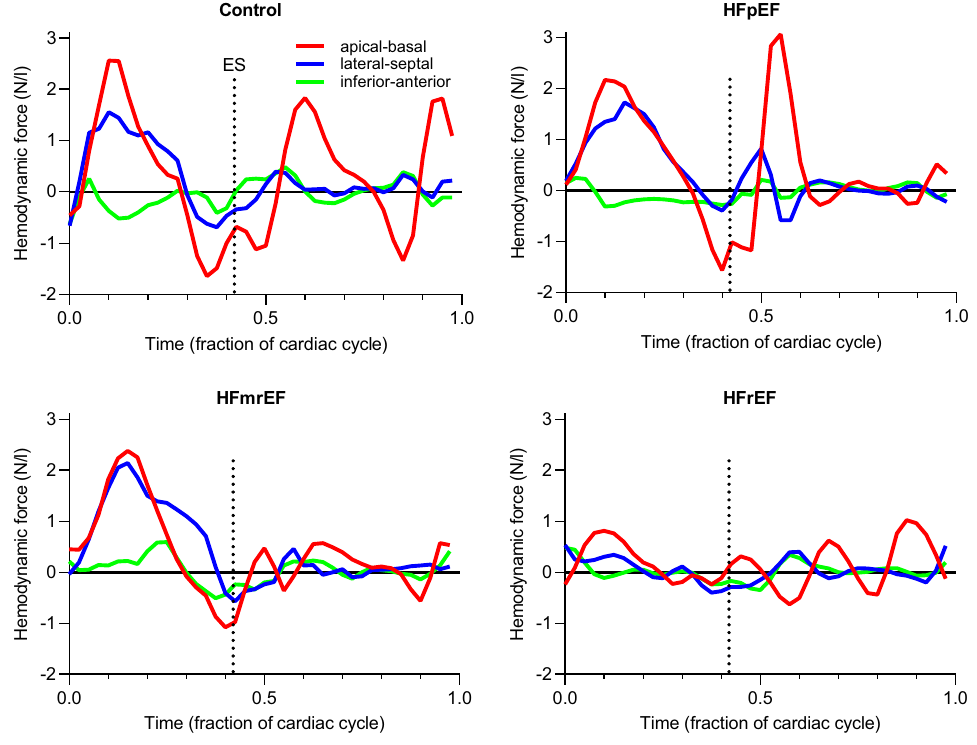
Figure 2. Examples of volume-normalized hemodynamic force patterns in the four groups. The vertical dotted line denotes end systole